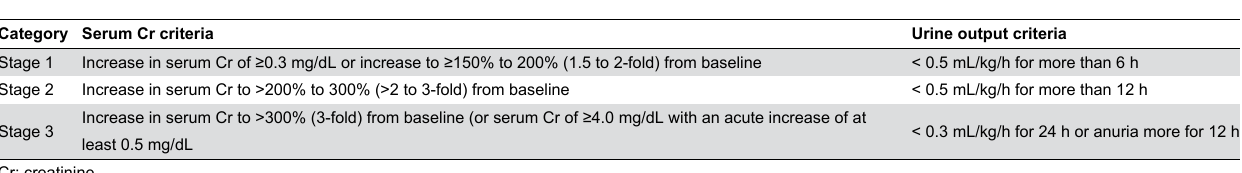
Table 2. AKIN scoring